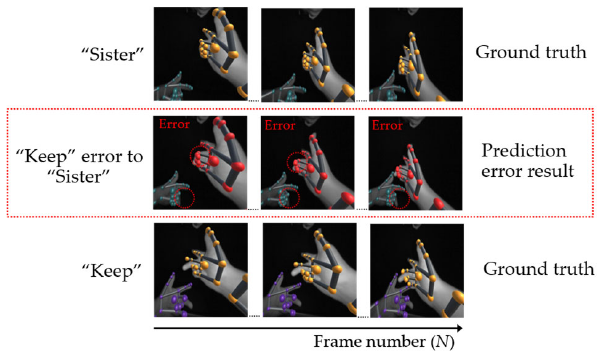
Figure 17. Example of a double ‐ hand word error caused by a finger.